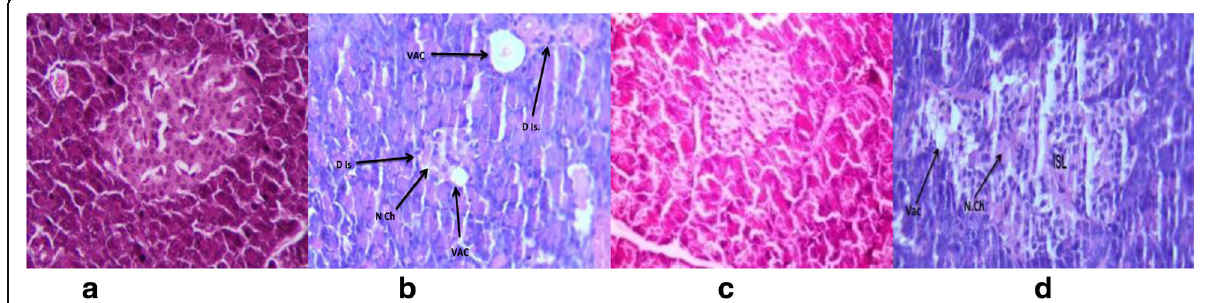
Fig. 2 Liver pathology. Histopathological graphs show a photomicrograph showing the normal histological architecture of the control rat pancreas, normal acinar structure with normal islets. b Pancreas of positive control group induced diabetic with STZ, showing marked reduction in islets of Langerhans with marked degenerative changes and necrotic tissue; all the islets acini showing marked atrophy degenerative and vaculation changes. c Pancreas of Diamicron-treated group showing restoration of normal size of islets of Langerhans with normal endocrine cell distribution with mild necrotic tissue. d Photomicrograph of pancreas of nano-curcumin-treated group showing moderate restoration of cells of islets of Langerhans with mild necrotic